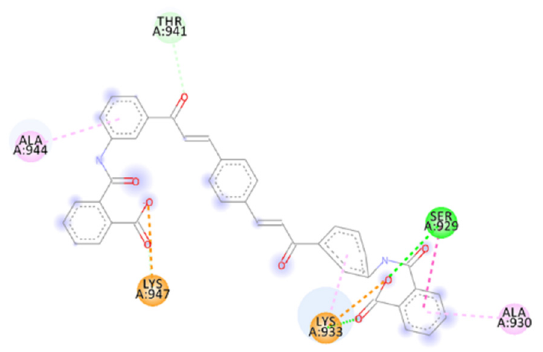
Figure 5. Calculated 2D interactions for ZINC00097961973 in complex with SARS-CoV-2’s HR1 domain.